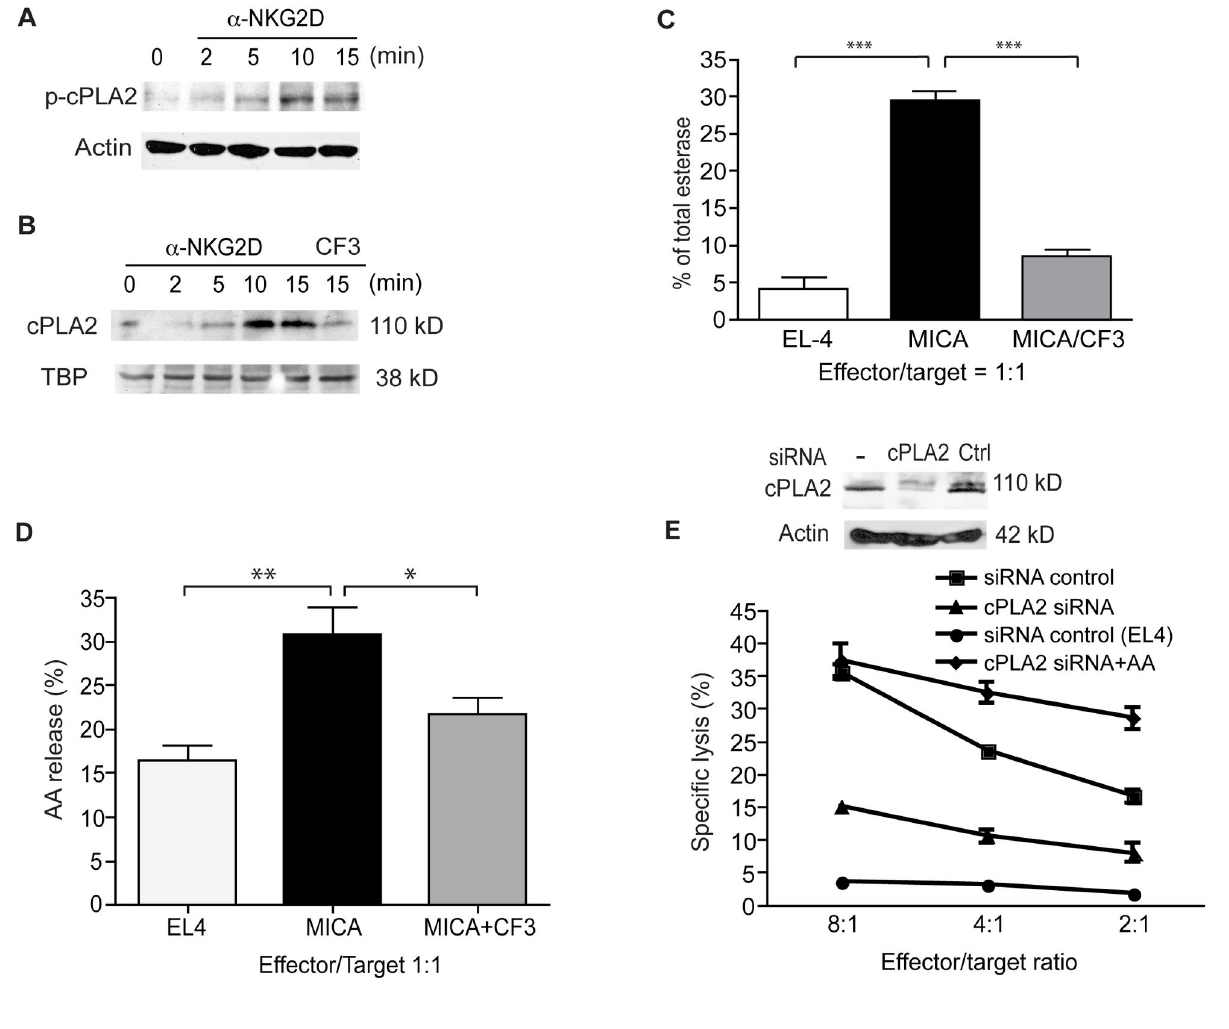
Figure 1. cPLA2 is activated in NK cells and is critical for the production of AA and for cytolysis in response to NKG2D. ( A ) cPLA2 is phosphorylated in response to NKG2D stimulation in NKL cells. Cells were stimulated with an anti-NKG2D mAb for the indicated time and probed for cPLA2 phosphorylation using a phospho-cPLA2-specific antibody. Data are representative of three independent experiments. ( B ) cPLA2 translocates to the nucleus in response to NKG2D stimulation in NKL cells. Nuclear extracts were probed using an anti-cPLA2 mAb. TATA binding protein (TBP) is shown as a loading control. Data are representative of three independent experiments. ( C ) NKG2D-mediated cytotoxicity of NKL cells was dramatically reduced upon inhibition of cPLA2 using the pharmacological inhibitor AACOCF3 (CF3). Data are means +/- SD of three independent